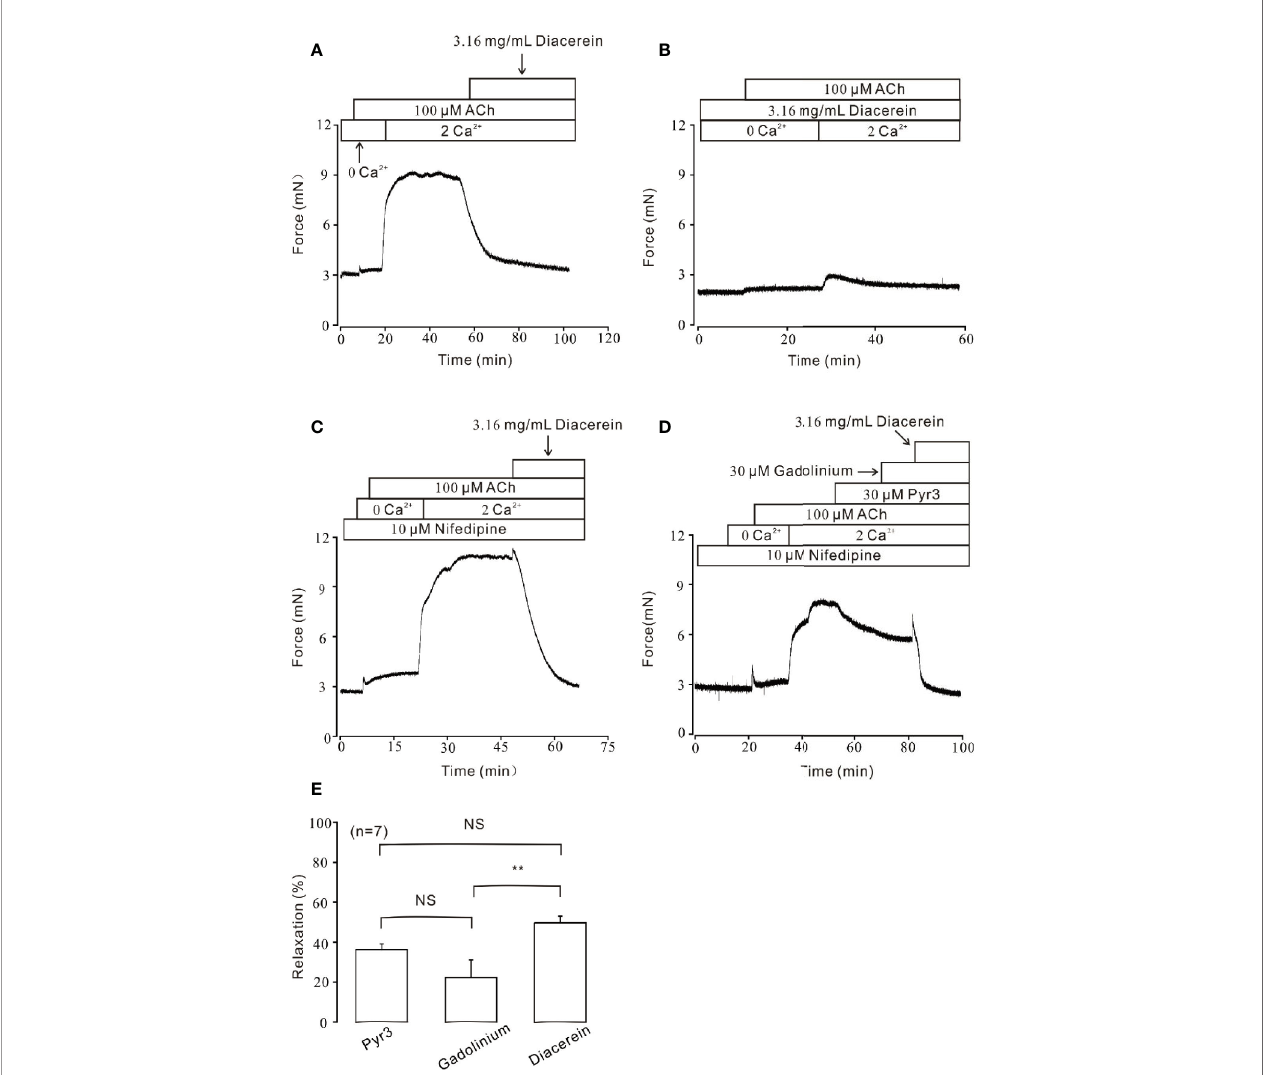
FIGURE 6 | Diacerein blocked ACh-induced Ca 2+ in fl ux. (A) Under Ca 2+ -free condition, 100 m M ACh could evoke a small and transient contraction which indicated intracellular calcium was released. After the restoration of 2 mM Ca 2+ , a large and steady contraction was observed, and inhibited by 3.16 mg/ml diacerein subsequently. (n = 6/6 mice). (B) In the presence of 3.16 mg/ml diacerein, 100 m M ACh failed to induce contraction on mouse tracheal rings (TRs) either under Ca 2+ -free condition or after 2 mM Ca 2+ restoration (n = 6/6 mice). (C) The similar 100 m M ACh-induced contraction and 3.16 mg/ml diacerein-induced relaxation as shown in ( A ) occurred when voltage-dependent L-type Ca 2+ channels (VDLCCs) were excluded with 10 m M nifedipine (n = 6/6 mice). (D) In the presence of nifedipine, ACh-induced contraction in 2 Ca 2+ solution could be reversed by 30 m M Pyr3, 30 m M gadolinium, and 3.16 mg/ml diacerein, sequentially (n = 7/7